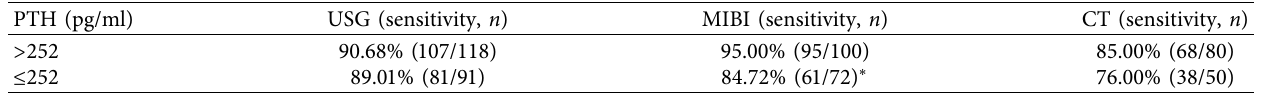
Table 5: Sensitivity of imaging methods in two groups classified by serum PTH. PTH (pg/ml)